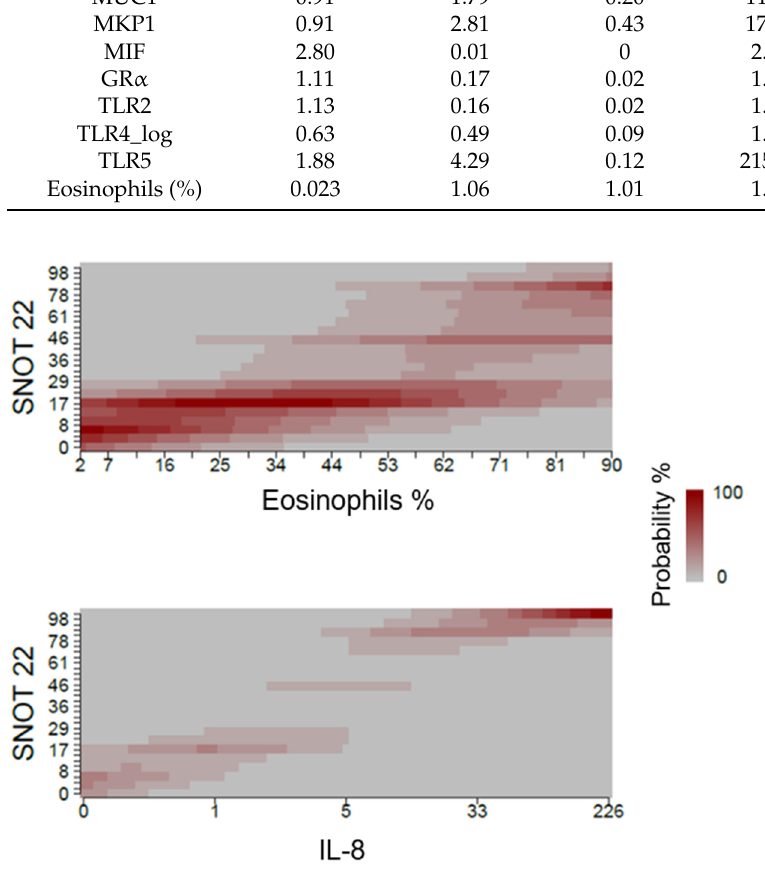
Figure 1. Association between SNOT-22 and the molecular parameters eosinophils and IL-8. The expression of target genes was expressed as 2 elevated—deltaCt.